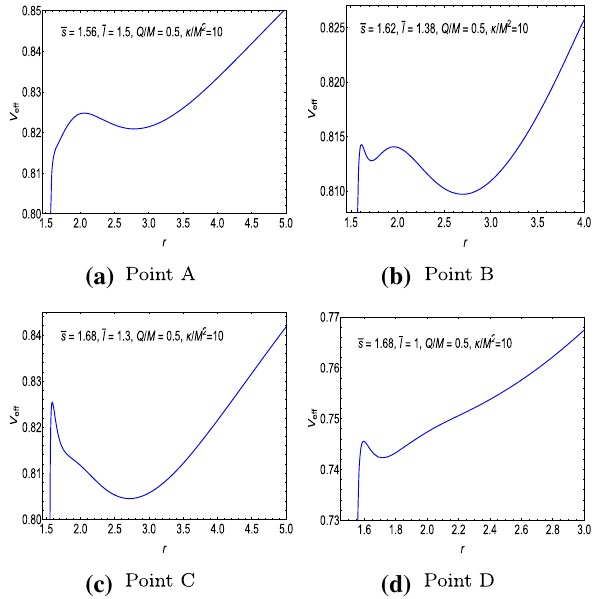
Fig. 8 The shapes of potential referring to points A, B, C and D in Fig. 7c κ when the particle’s spin is small. However, as shown in Fig. 7f, when the spin becomes large enough, r ISCO , and ¯ e ISCO will first decrease and then increase with κ . Espe- cially, for ¯ s = 1 . 6, there is another possible ISCO when κ/ M 2 > 9 . 641, which is superluminal and decreases with κ . The constraint from the existence of neutron stars